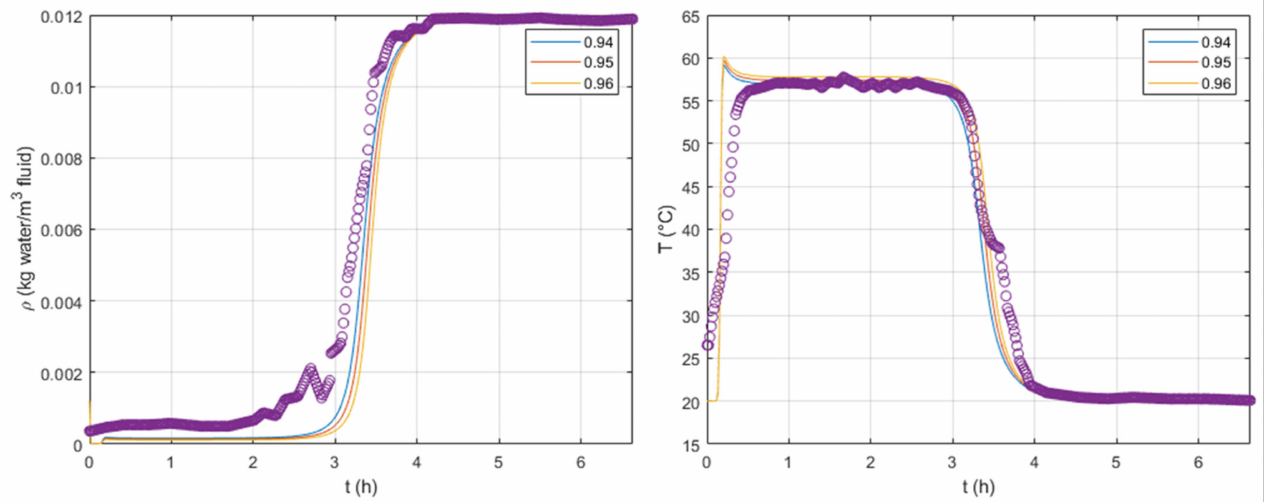
Figure 4. Sensitivity analysis of the intra-crystalline diffusivity, D c 0 , at T c 0 = 298 K onto concentration and temperature profiles. Experimental data with the symbol and simulated response in lined-curves. (cid:35)